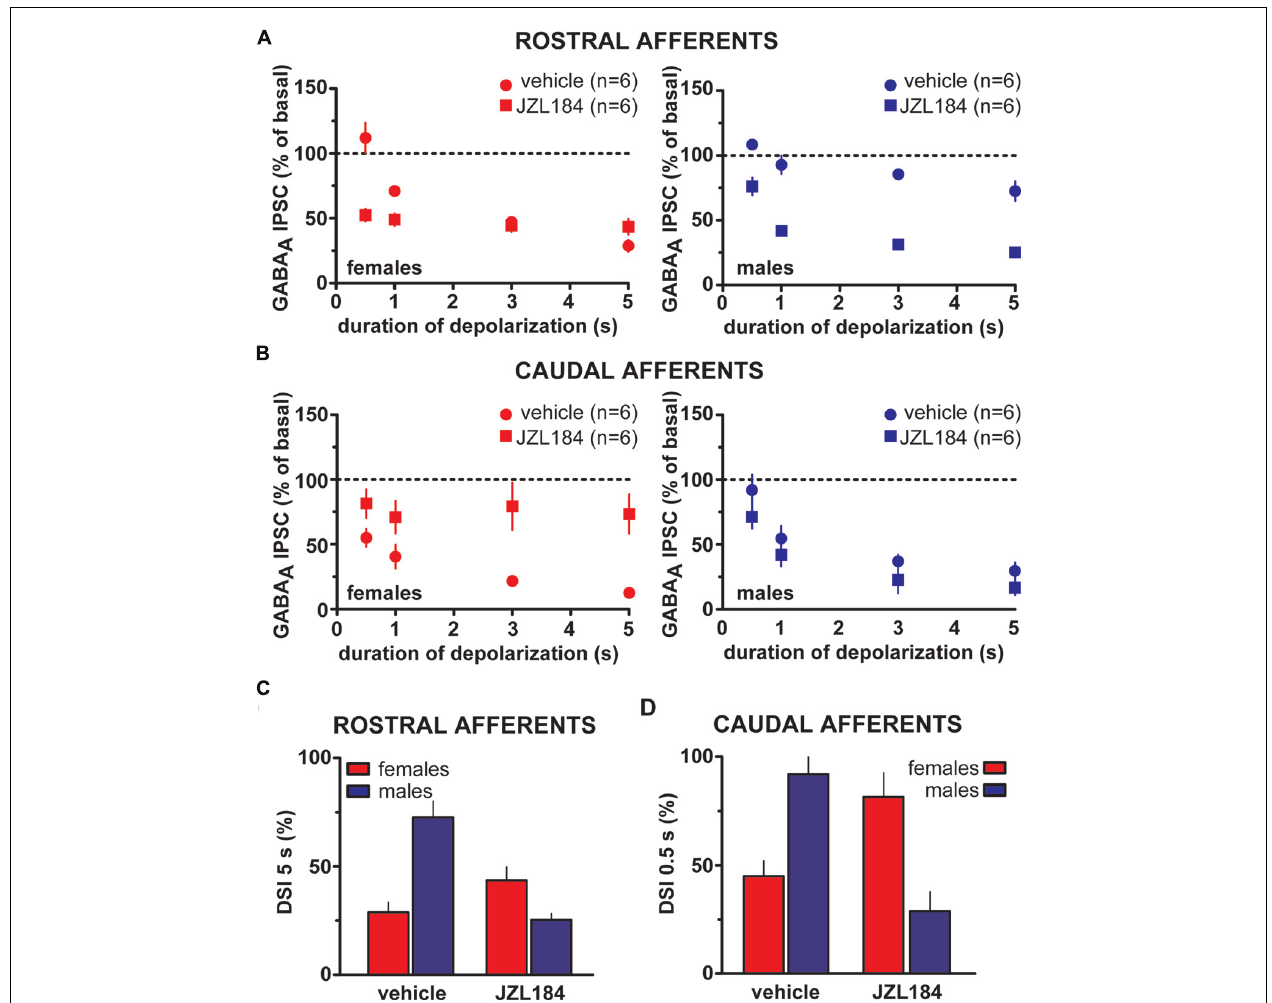
FIGURE 6 | Effect of MAGL inactivation on strength of DSI in male and female LH rats. (A) The relationship between the depolarizing pulse duration and the relative amplitude of rostral GABA A IPSCs obtained after 5–15 s after the end of depolarization in the presence (square symbols) and absence (circles) of MAGL inhibitor JZL184 in female (left panel) and male (right panel) LH rats is plotted. GABA A IPSCs amplitude was normalized to the averaged value (dotted line) before depolarization. Each symbol represents the averaged value obtained from different cells. (B) The relationship between the depolarizing pulse duration and the relative amplitude of caudal GABA A IPSCs obtained after 5–15 s after the end of